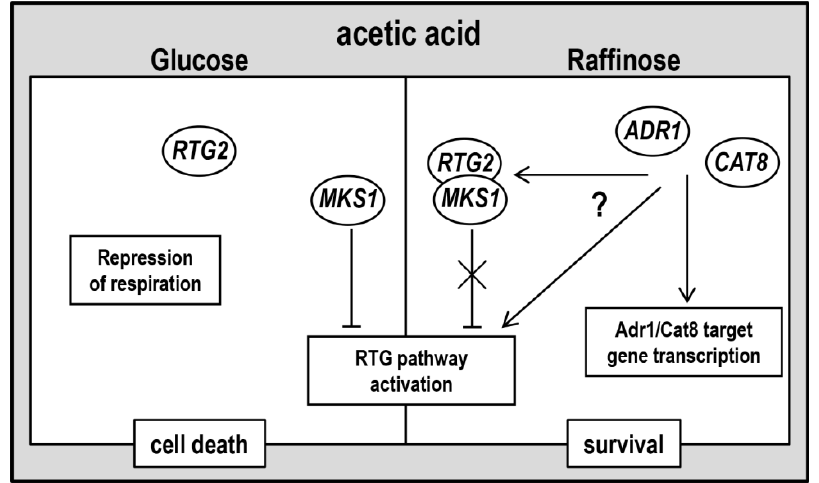
FIGURE 4: A working hypothesis model for yeast acetic acid-stress response regulation by RTG and CCR pathways. Exponential glu- cose-grown cells undergo PCD in response to acetic acid with simultaneous repression of respiration and of RTG pathway. Raffinose- grown cells evade AA-PCD with de-repressed respiration [16] and RTG pathway